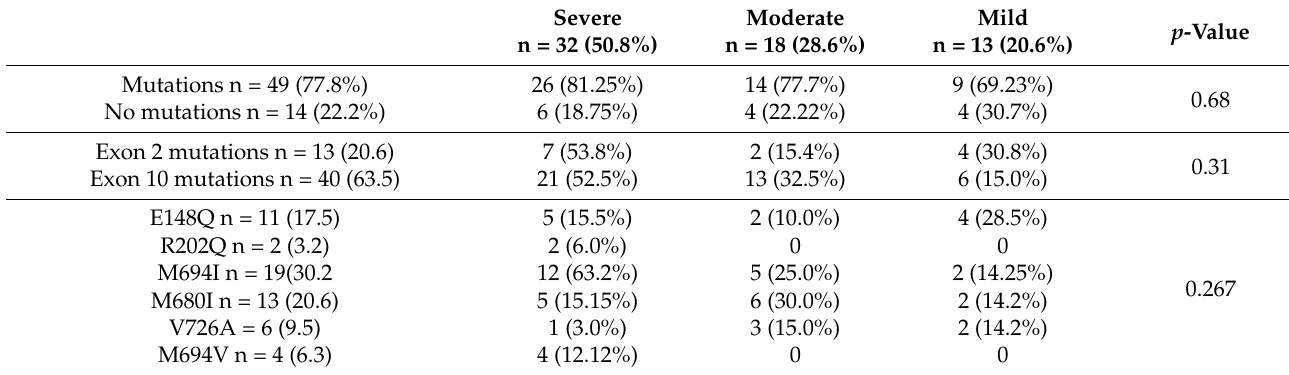
Table 5. Disease severity and